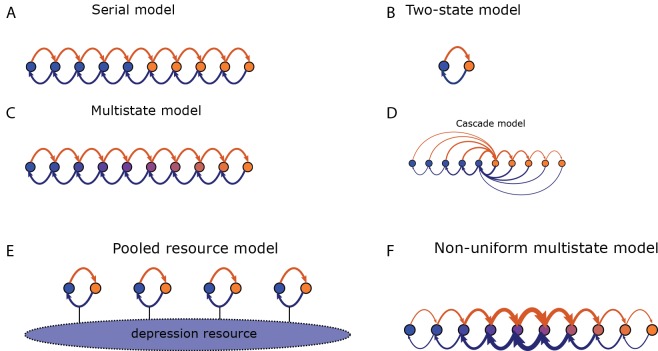
Transition probabilities for different models.Potentiation induces transitions indicated by orange arrows, depression indicated by blue arrows. States of strong/weak synaptic weight indicated by orange/blue circles. (A) In the serial model the transition probabilities for potentiation/depression are all equal and it is parameterised by these two values. The synaptic weight takes only two values, ±1. (B) The two-state model is parameterised by the two transition probabilities. (C) In the multistate model the transition probabilities for potentiation/depression are all equal and it is parameterised by these two values. The synaptic weight varies linearly in the interval [−1,1]. (D) In the cascade model, the transition probabilities decay geometrically with a parameter x (see Fusi et al., 2005) and synaptic weight takes only two values. (E) In the pooled resource model, Several two-state synapses share resources that are required for potentiation and depression. These resources are depleted as more synapses are potentiated or depressed. This pool of synapses can be modelled as one compound synapse. (F) In the non-uniform multistate model the synaptic weight varies linearly in the interval [−1,1], similar to the multistate model, but the transition probabilities between adjacent states decays exponentially away from the central transition for both potentiation and depression.